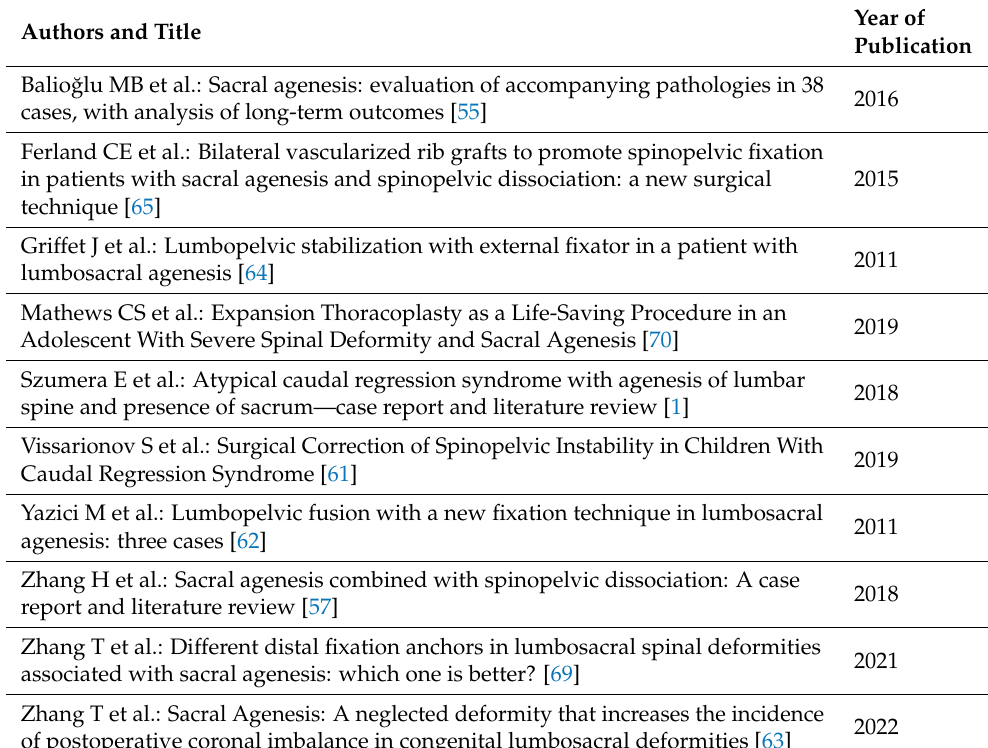
Table 2. The most interesting papers on spine in caudal regression syndrome, published in recent years. Authors and